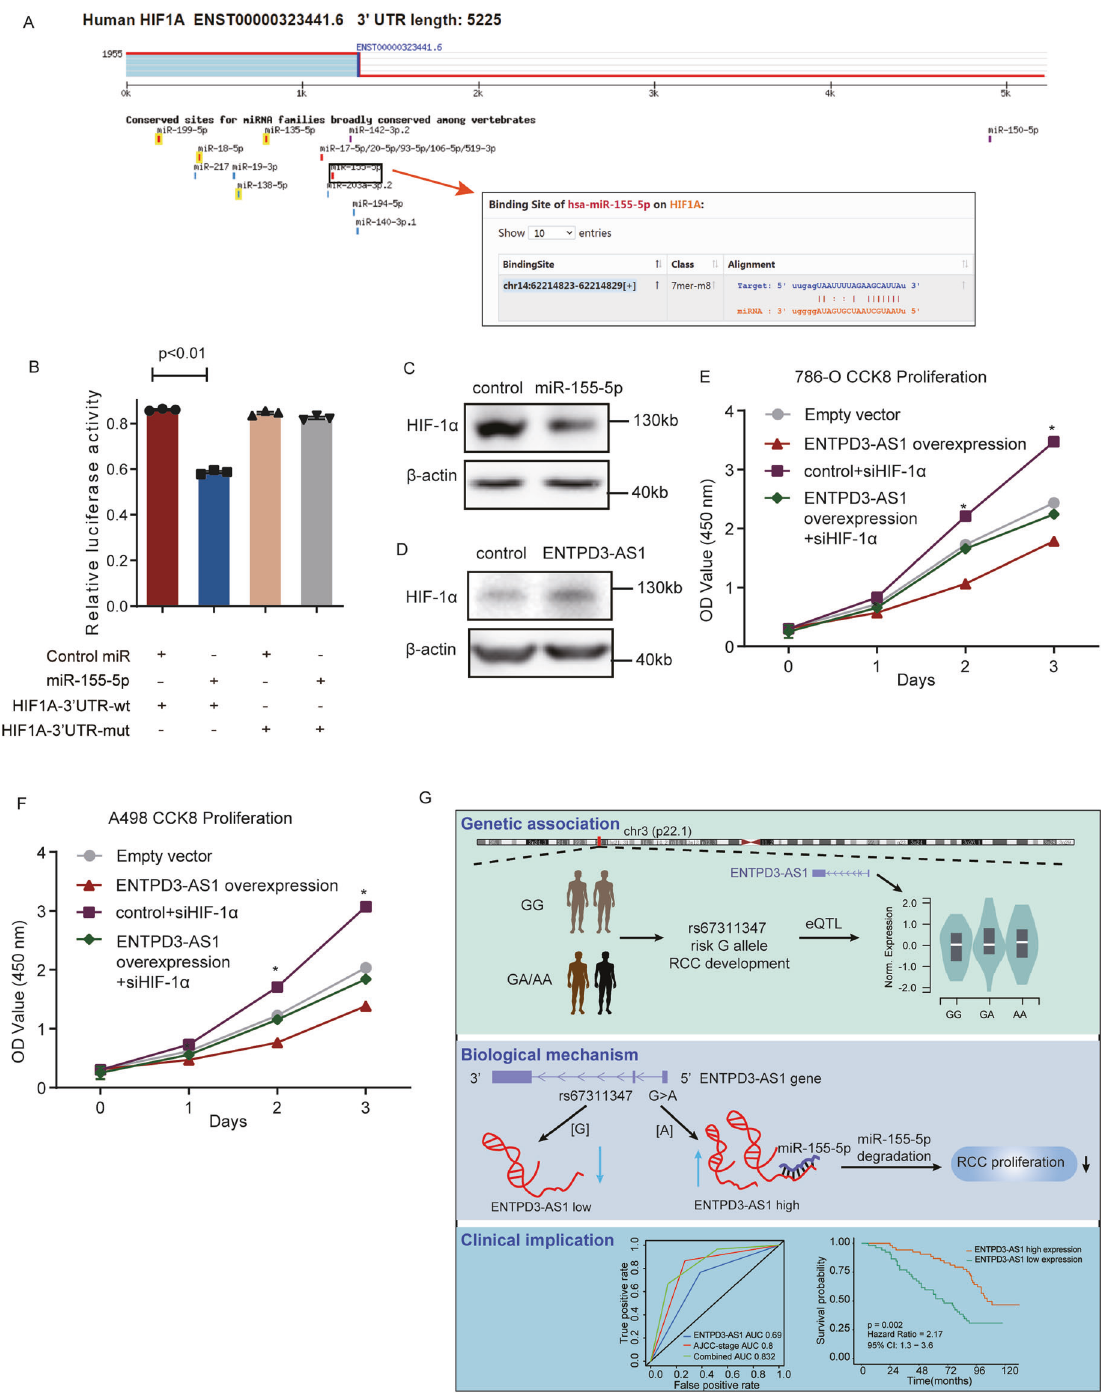
Fig. 6 miR-155-5p promoted RCC development by regulating HIF-1 α . A The potential target gene of miR-155-5p in TargetScanHuman database. B The direct interaction between miR-155-5p and HIF-1 α by luciferase assays. C The expression of HIF-1 α after overexpression of miR-155-5p. D The expression of HIF-1 α after overexpression of ENTPD3-AS1. E , F Knockdown of HIF-1 α rescued ENTPD3-AS1 overexpression inducing a decrease in cell proliferation. G SNP-mediated lncRNA-ENTPD3-AS1 upregulation suppresses renal cell carcinoma via miR-155/HIF- 1 α